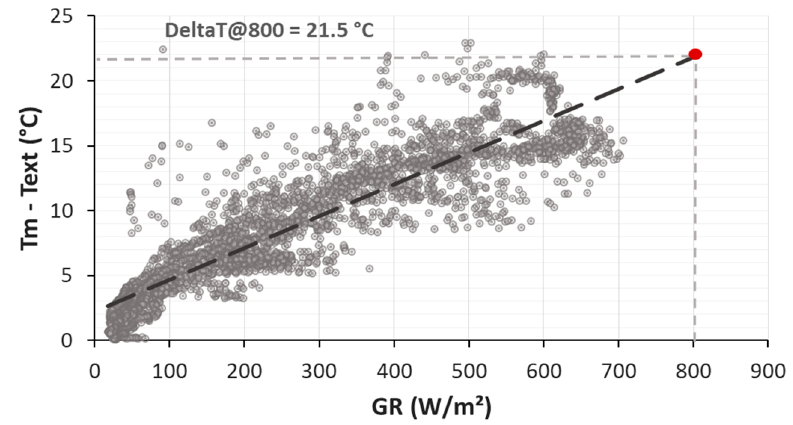
Figure 12. Difference between DSM intrados temperature (Tm) and external temperature (Text) versus solar irradiance for the determination of NOST.